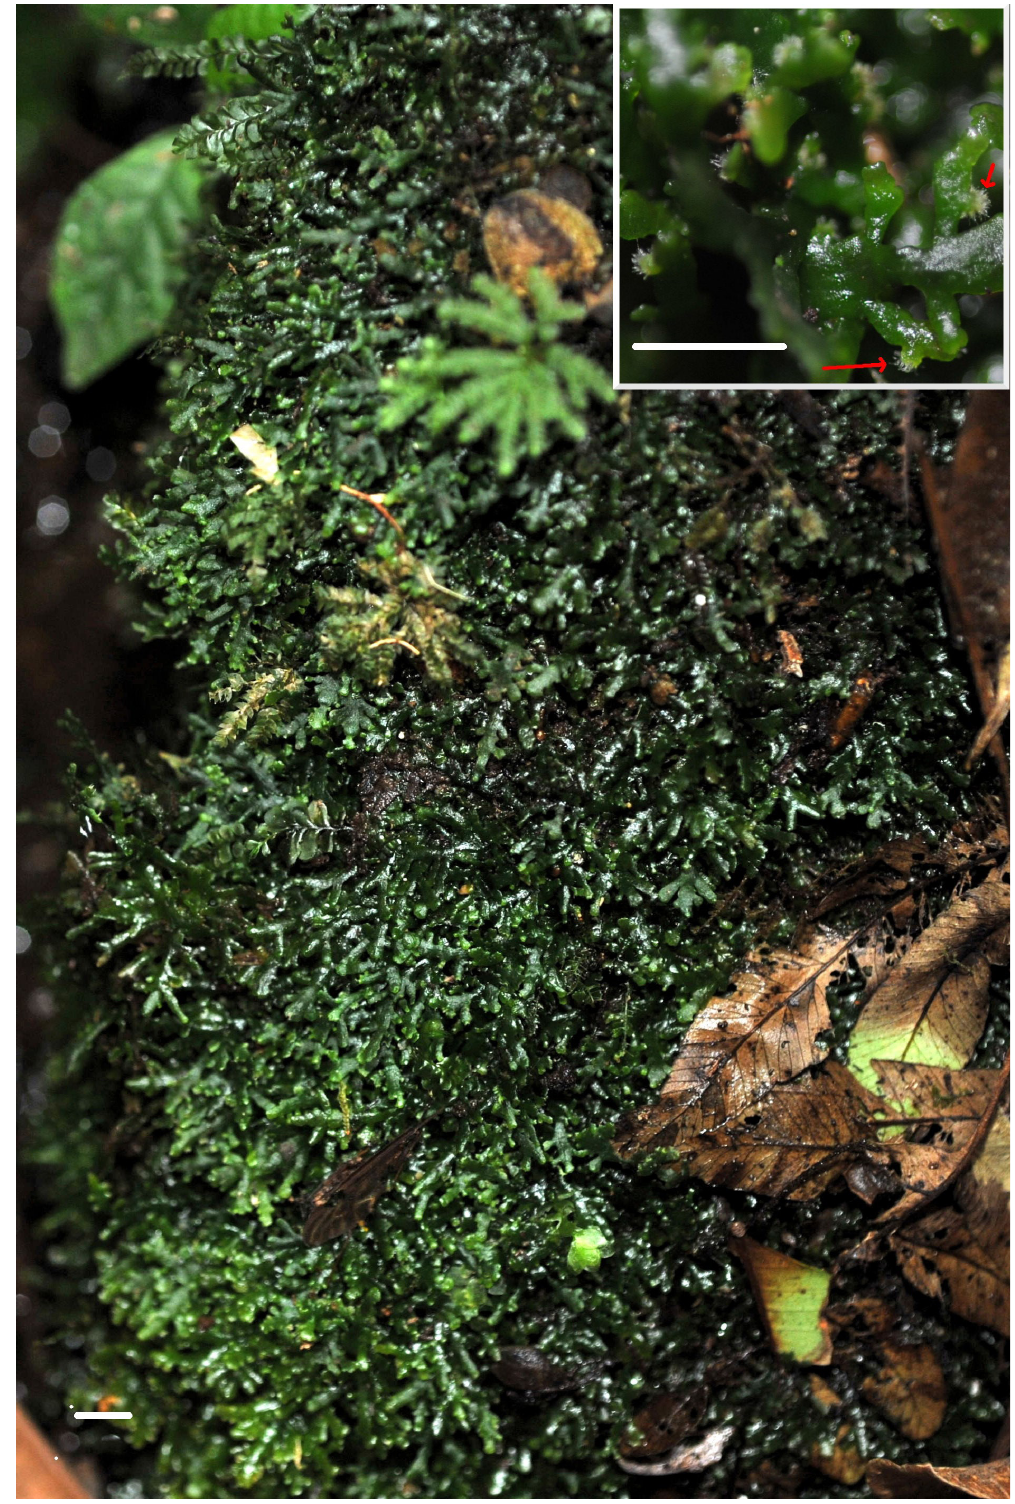
Fig. 3. Afroriccardia comosa (Steph.) Reeb & Gradst. comb. nov. Population close to sample CR13Z28 , Zahamena National Park, Alaotra-Mangoro, Madagascar, 17°37′19″ S, 48°37′46″ E, altitude 1196 m. A . Photographs of the thallus. B . Magnified view of the thallus showing solitary female branches (red arrows). Scale bars = 1